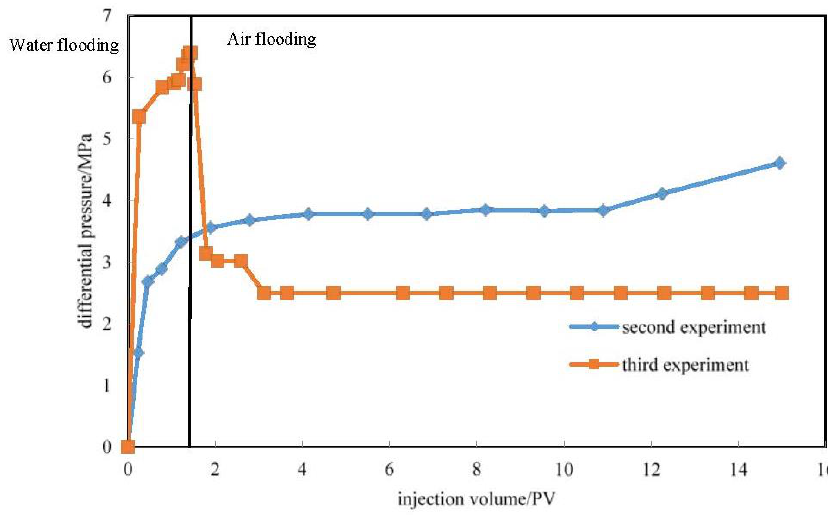
Figure 12. The second and the third group experiments of pressure difference and multiple injection contrast analysis.